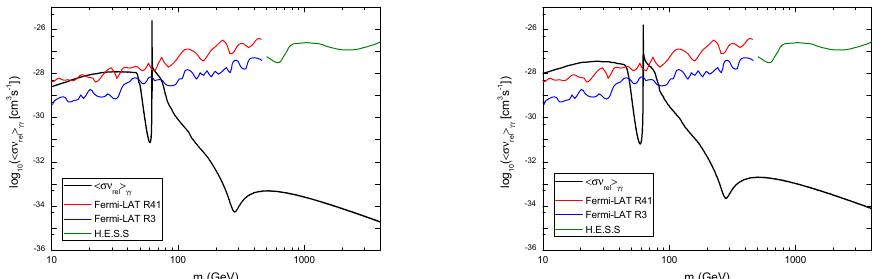
Figure 3 . Constraint from gamma ray spectrum at Fermi-LAT and HESS in the model A ( left ) and model B ( right ),